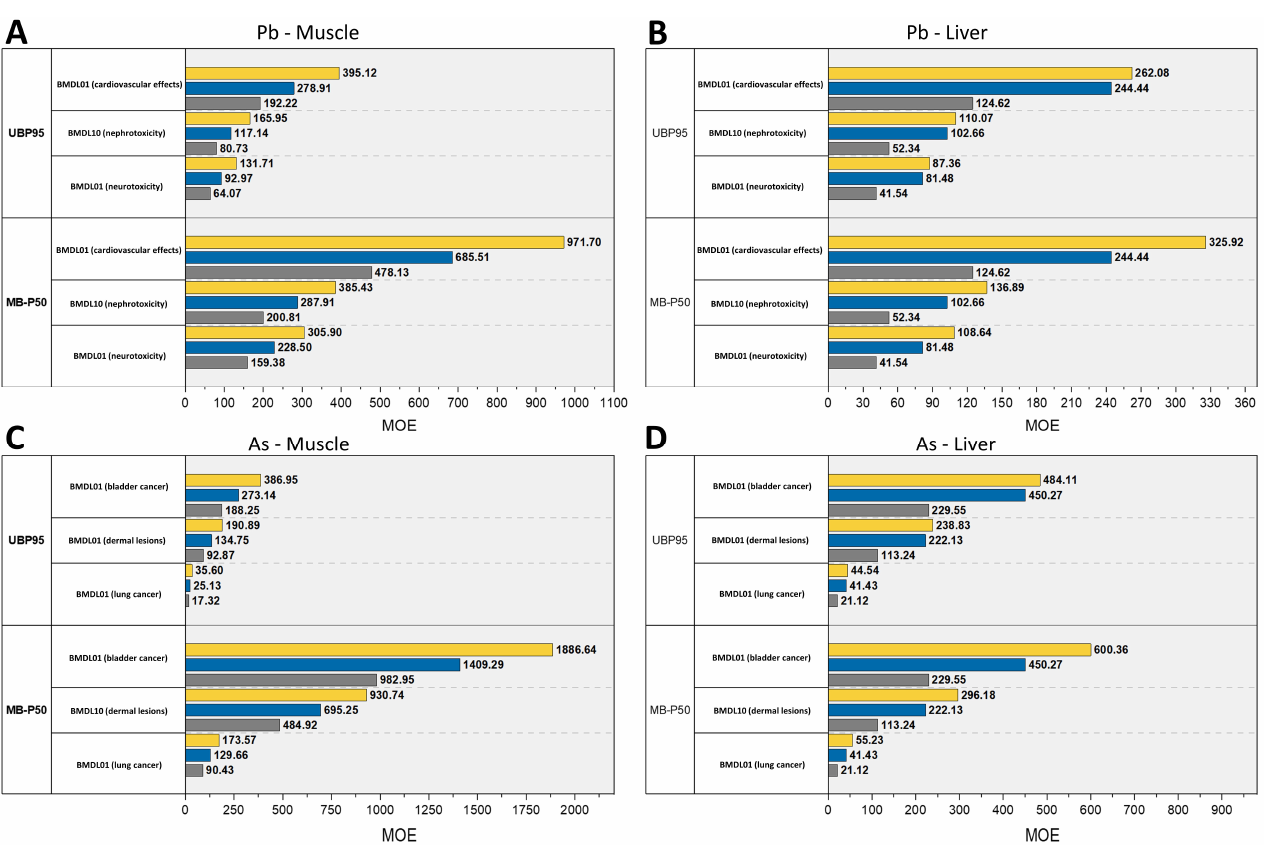
Figure 4. Comparison between margins of exposure (MOEs) to i As and Pb (dimensionless, calculated as the ratio between BMDLs and EDIs) for the Italian population age groups related to the consumption of pig meat ( A , B ) and pig liver ( C , D ) (yellow bars: adults; blue bars: adolescents; gray bars: children). MOEs were calculated according to the less pessimistic (MB ‐ P50, A , C ) and worst ‐ case (UB ‐ P95, B , D ) dietary exposure scenarios.